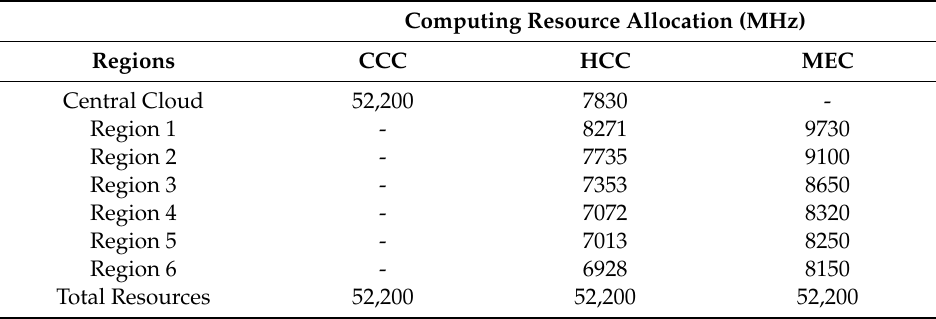
Table 2. Computing resource allocation for three